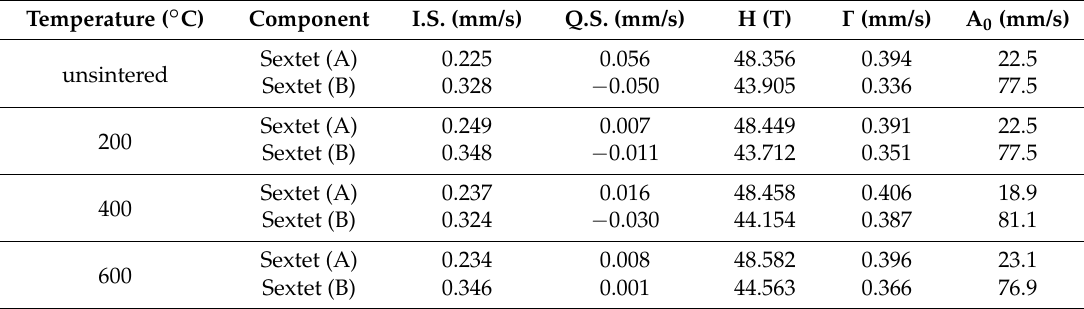
Table 4. Mössbauer parameters of Co 0.9 Zn 0.1 Fe 2 O 4 calcined at different temperatures.